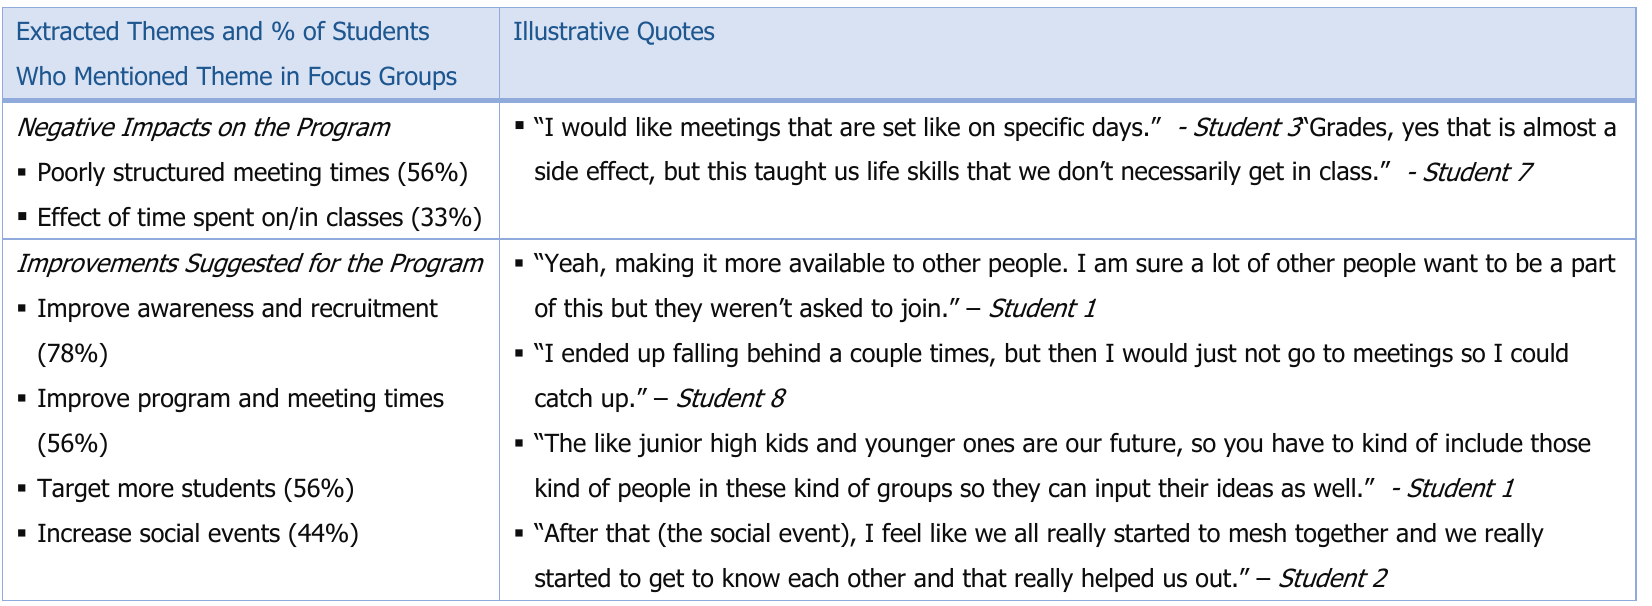
Table 3: Focus Group Discussion Themes, Their Frequencies, and Illustrative Quotes (continued) Extracted Themes and % of